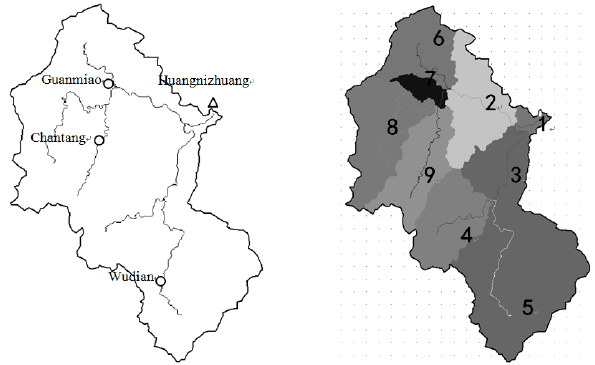
Figure 2. The location of the study area and the rainfall/discharge